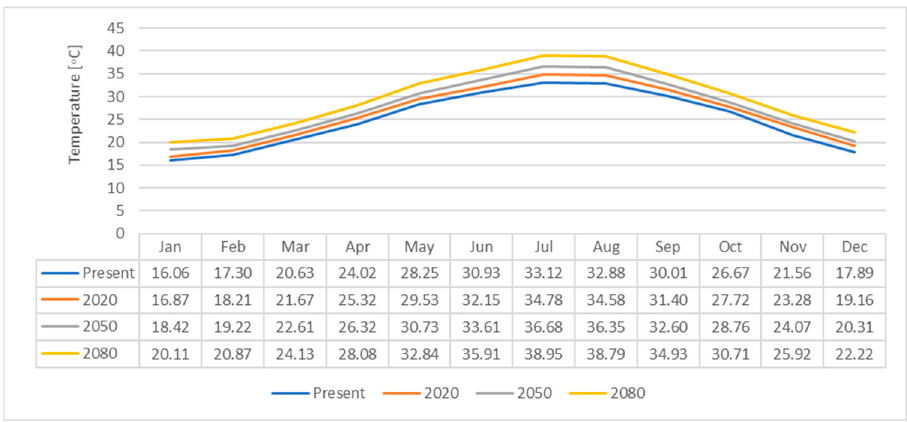
Figure 7. Monthly average temperatures for present and predicted weather in Hurghada.